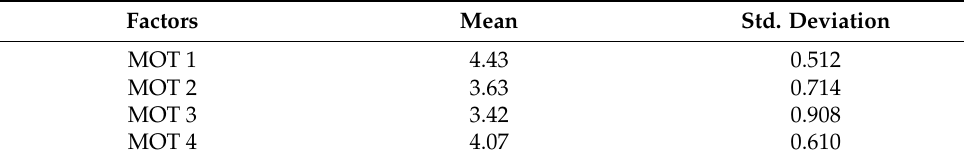
Table 5. Mean and SD of MOTs.